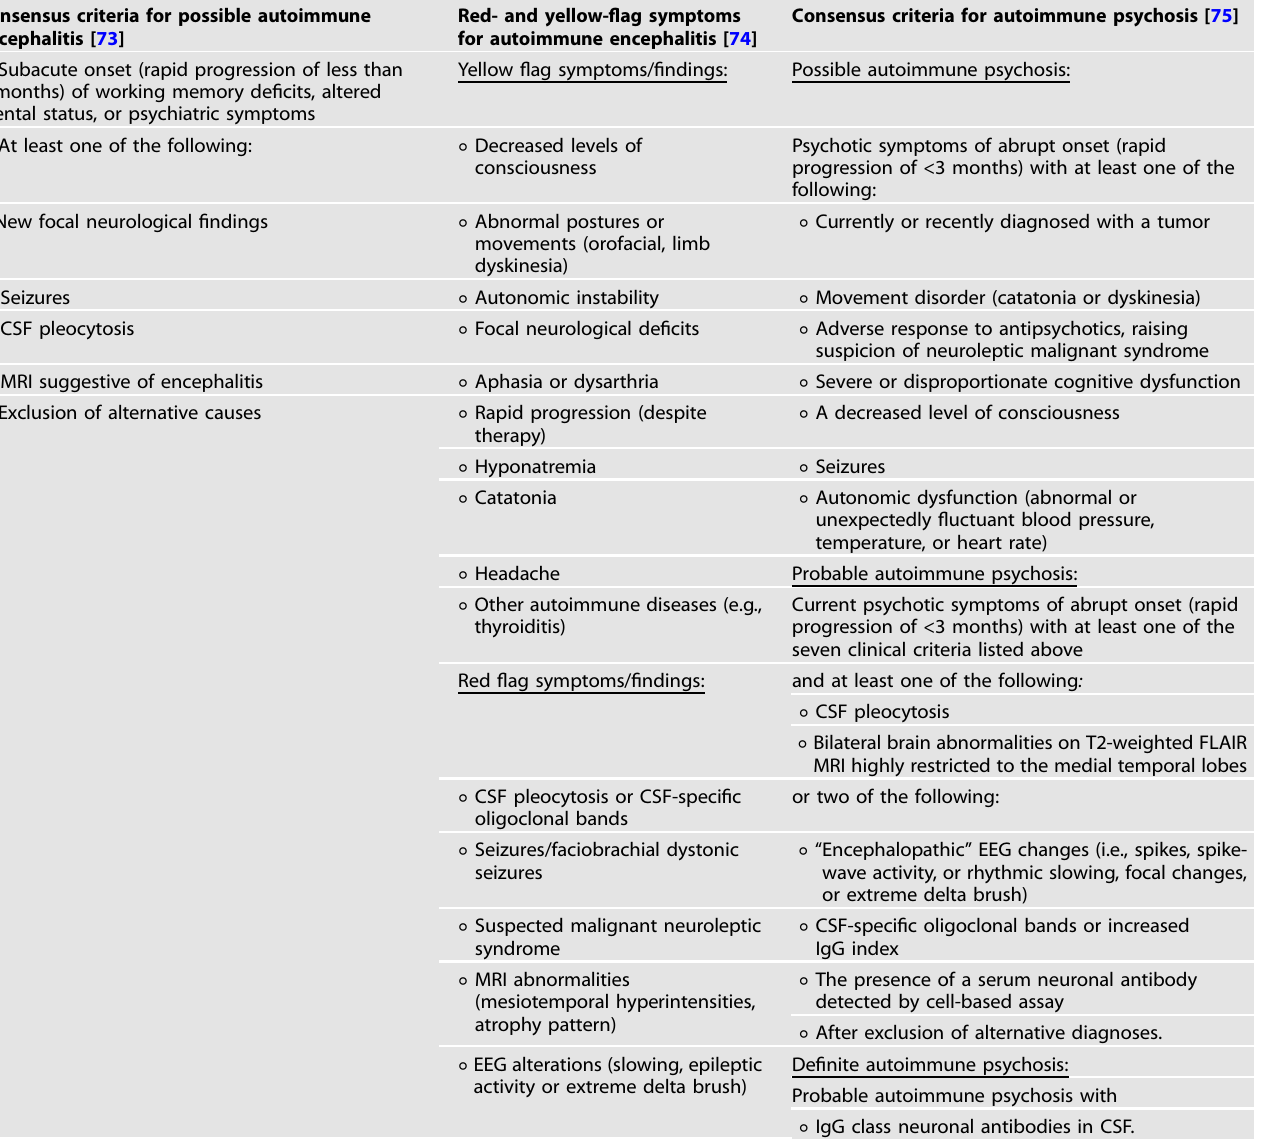
Table 2. Consensus criteria for autoimmune encephalitis and autoimmune psychosis, as well as red and yellow fl ag symptoms for autoimmune encephalitis in psychiatric patients [73 – 75]. Consensus criteria for possible autoimmune encephalitis [73]